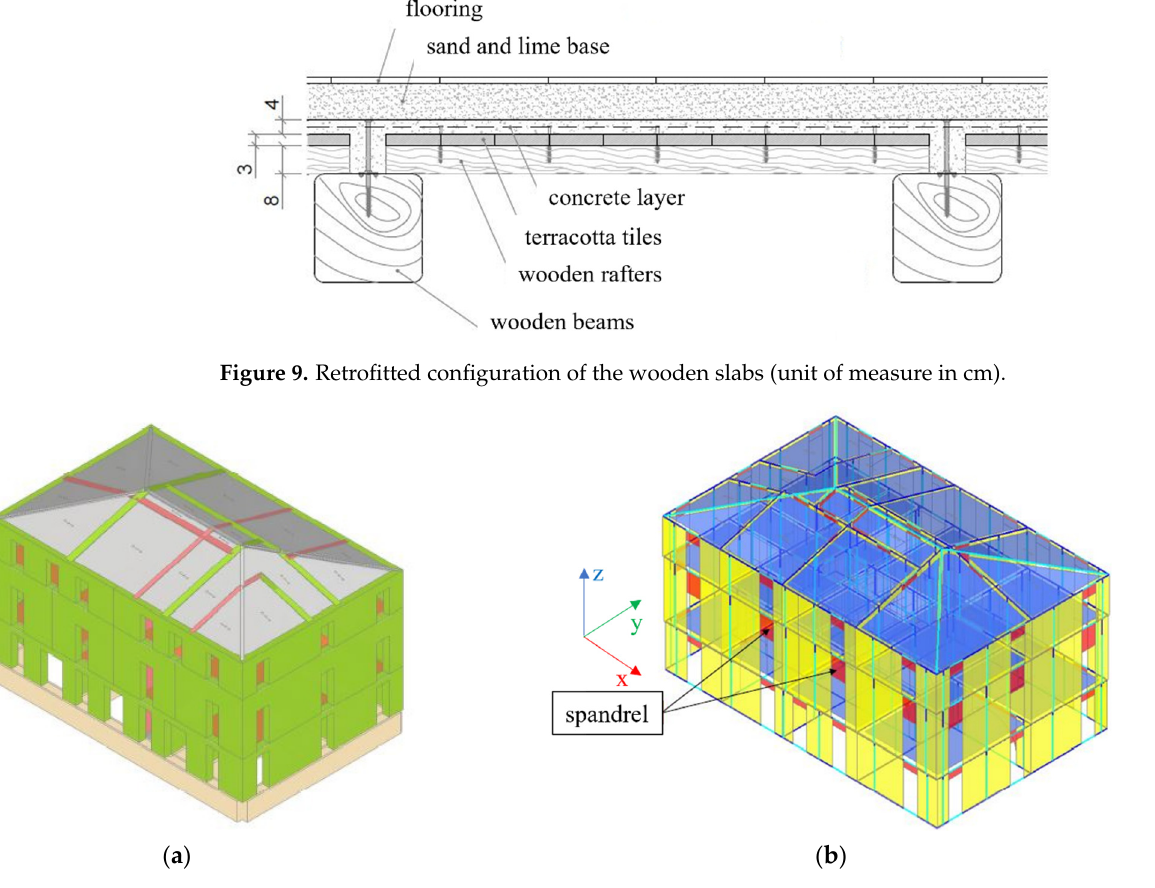
Figure 10. ( a ) 3D Finite Element model of the building (retrofitted configuration); ( b ) Equivalent frame model (retrofitted configuration).